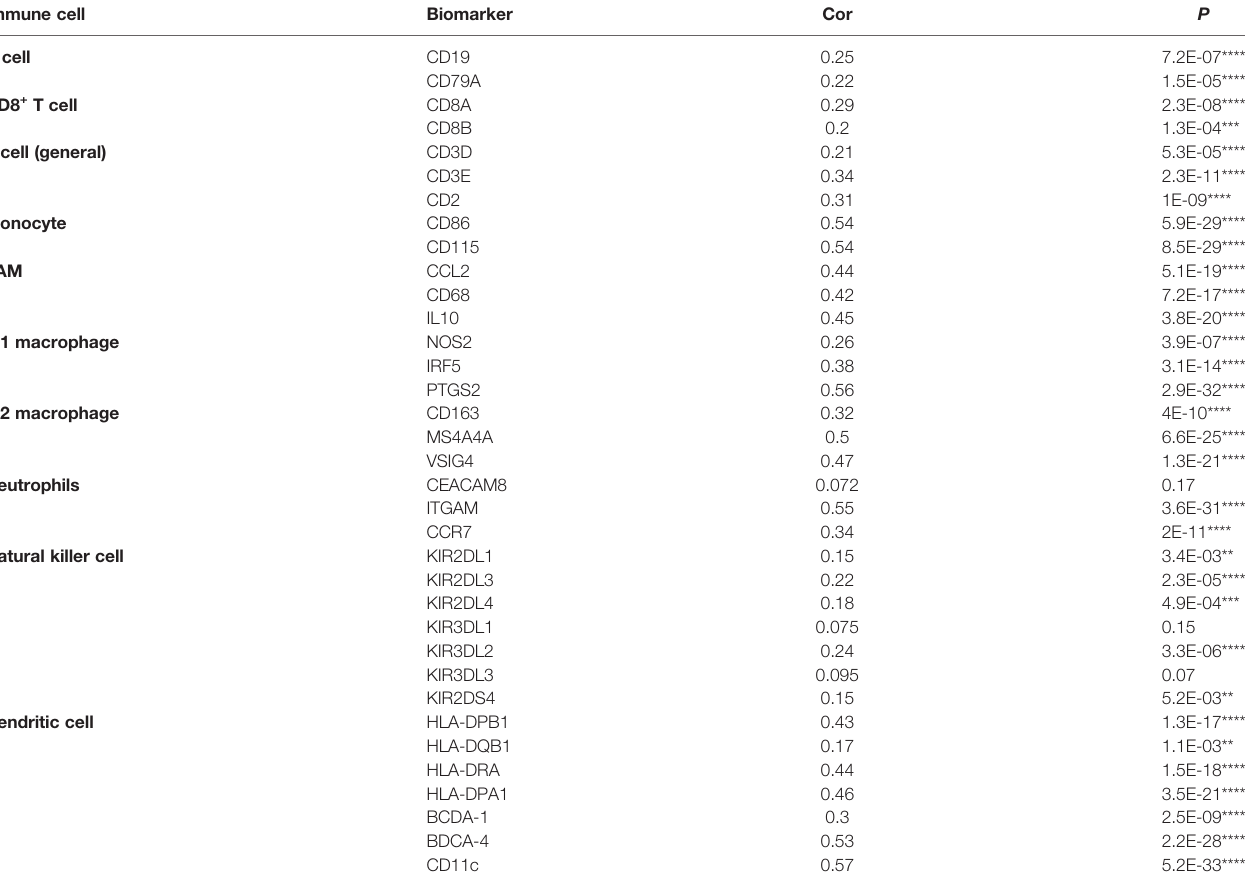
TABLE 3-1 | Correlation analysis between EOGT and biomarkers of immune cells in HCC in GEPIA2. Immune